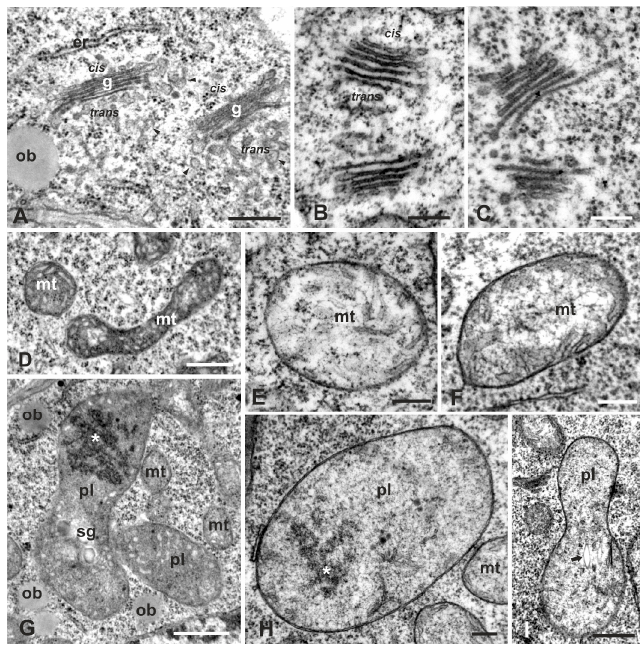
Figure 4. Effects of W on Golgi, mitochondria and plastids of cortex cells in the meristematic zone. ( A) . Control. Normal Golgi bodies (g) surrounded by numerous vesicles (arrowheads). ob = oil body. ( B , C) . Golgi bodies treated with 200 mg/L W for 12 h ( B ) and 24 h ( C ). In both treatments, Golgi bodies are similar in appearance, shorter than controls, highly contrasted and without any surrounding vesicles. D – F . Mitochondria (mt) of controls ( D ), 12-h ( E ) and 24-h ( F ) W-treated cortex cells. Control mitochondria display pleiomorphic shapes with profuse cristae ( D ), while in both W treatments they are oval and bear very few, barely viewable cristae in thin matrix ( E , F ). G – I . Plastids (pl) of control ( G ) and 24-h W-treated ( H , I ) cortex cells. Controls display varied morphology ( G ), while the W-treated ones are oval- or peanut-shaped, sparse stroma, without thylakoids or starch grains except for some remnants (arrow in I). Asterisks mark presumed protein deposits. ob = oil body, sg = starch grain. Scale bars: A, D, G, I = 0.5 μ M; B, C, E, F, H = 0.2 μ M.